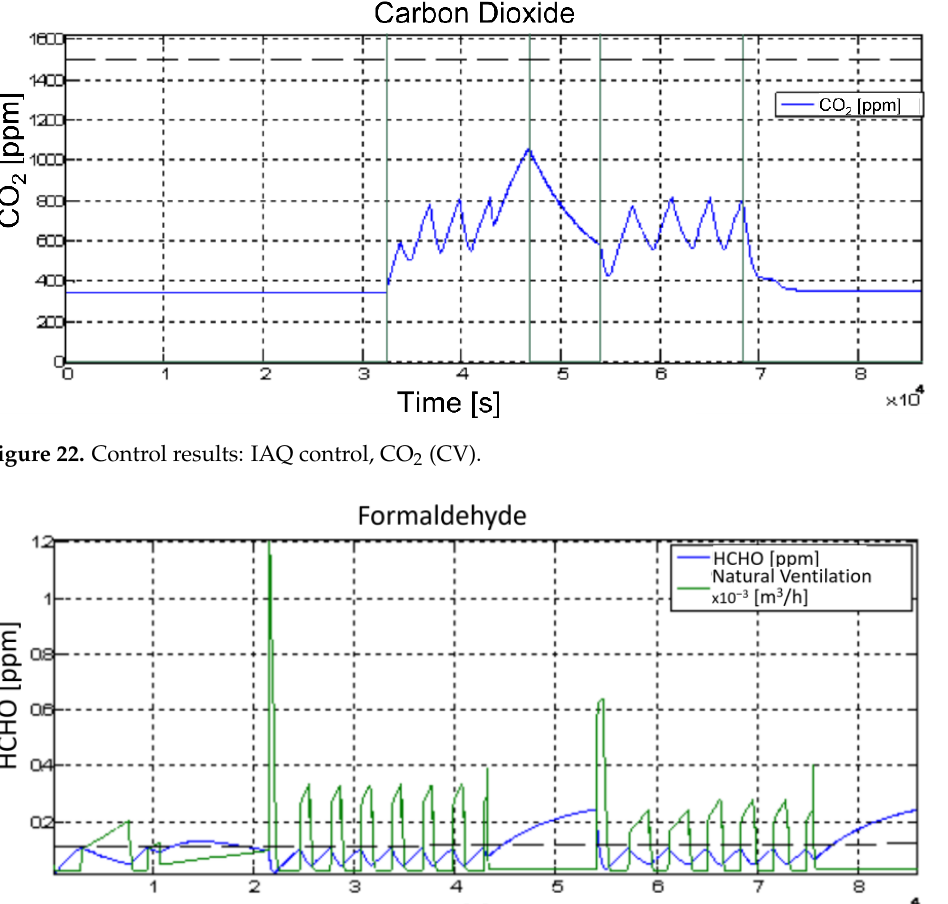
Figure 23. Control results: IAQ control, HCHO (CV).